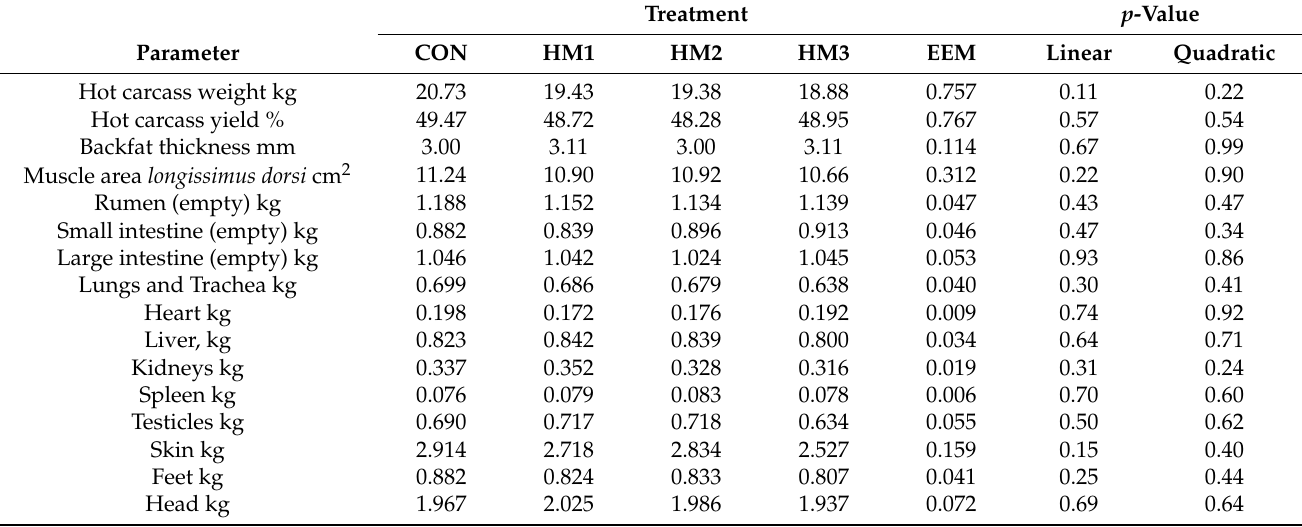
Table 2. Carcass traits and organ weights of lambs supplemented with a polyherbal mixture 1 during the final fattening